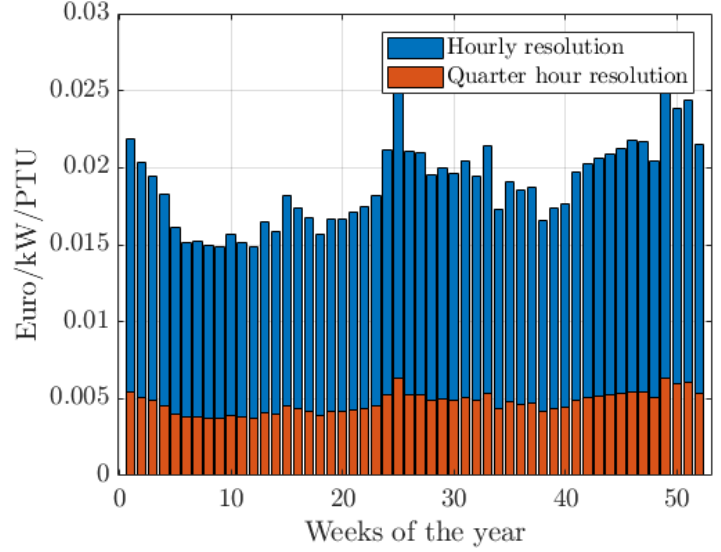
Figure 7. Up- and downregulation prices of the 2018 German